Question: Sum up the contents of this chart in one sentence.
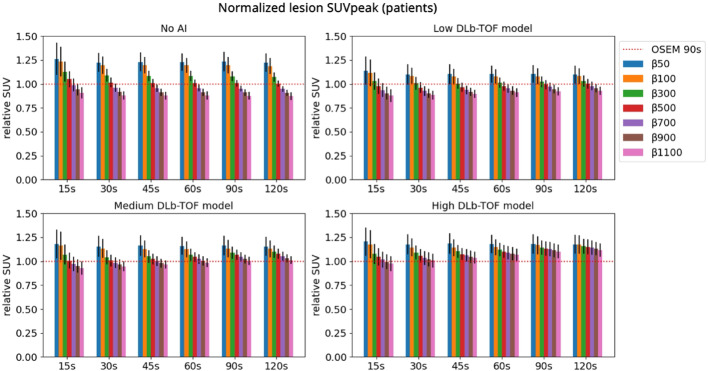
Answer: Lesion SUV peak value normalized to SUV peak of OSEM 90 s, as a function of acquisition time and β-value without (No AI) and with the three levels of DLb-TOF model (Low, Medium and High). The dotted line represents normalized SUV peak for 90 s acquisition time reconstructed with OSEM. Error bars indicate ± 1 SD